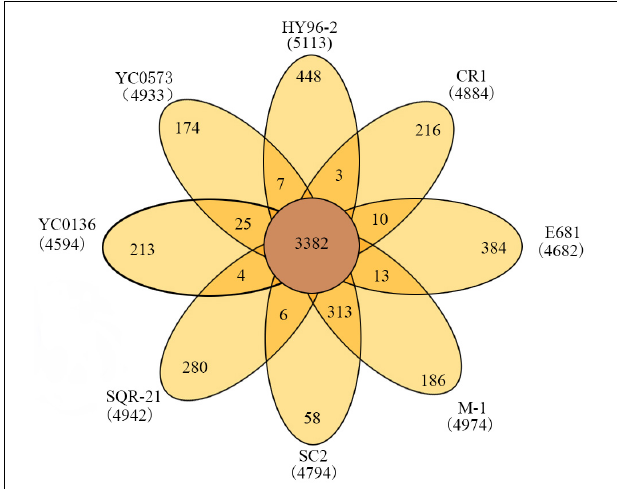
FIGURE 4 | Venn diagram showing numbers of specific and shared gene families among the eight different P. polymyxa